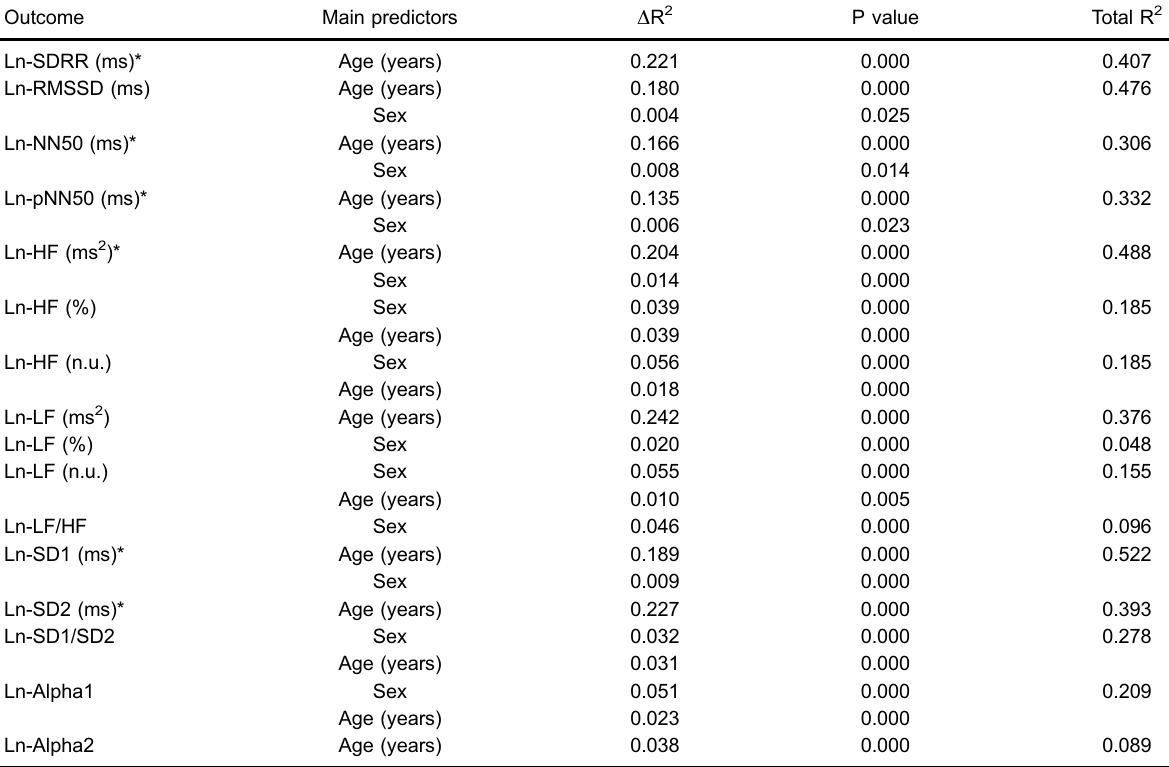
Table 1. Results of multiple regression analyzes with the in fl uence of age and sex as predictors of indices of heart rate variability.